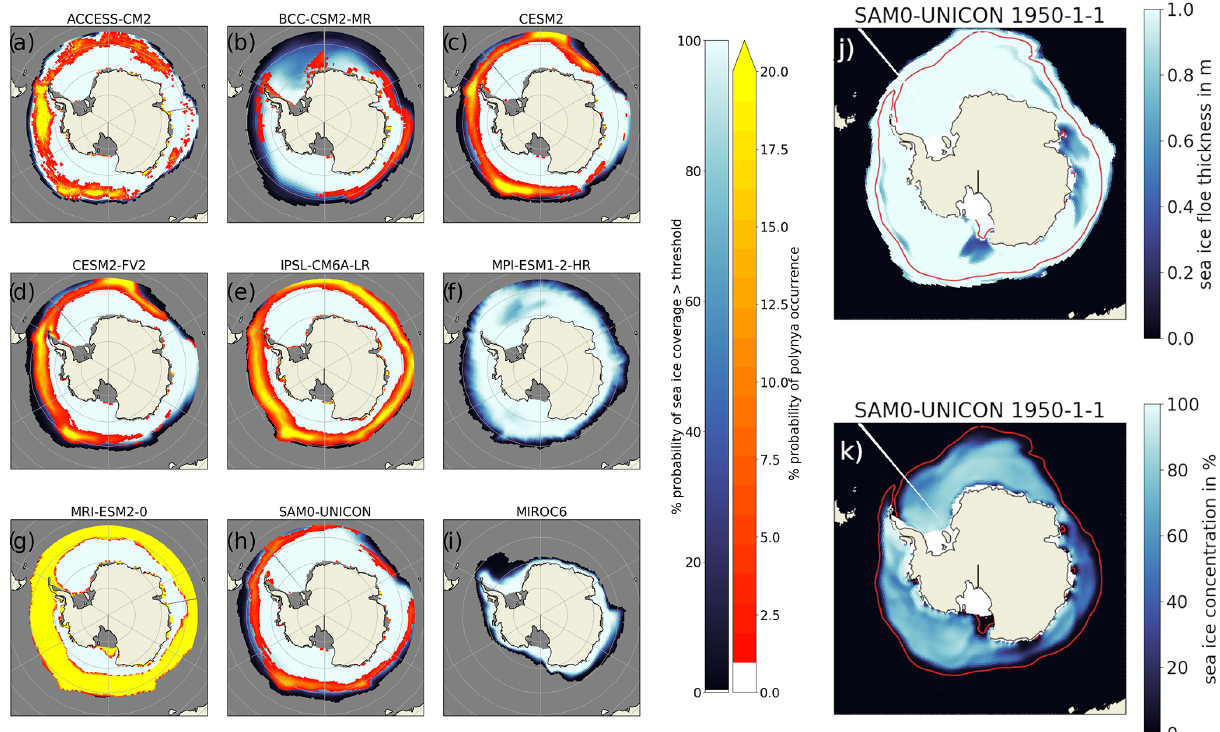
Figure 4. (a–i) Unrealistic “polynya areas” computed with a sea ice thickness threshold method from the ice floe thickness output data. (j–k) SAM0-UNICON sea ice floe thickness and sea ice concentration for one time step. The red-to-yellow colours indicate the number of years where polynyas were detected by our algorithm within the 165 years of the historical model run for each grid cell. The blue colours show the average sea ice concentration (in %). The red contour line in panels (j) – (k) marks the 1% sea ice concentration boundary. Open ocean and ice shelves both appear in grey.